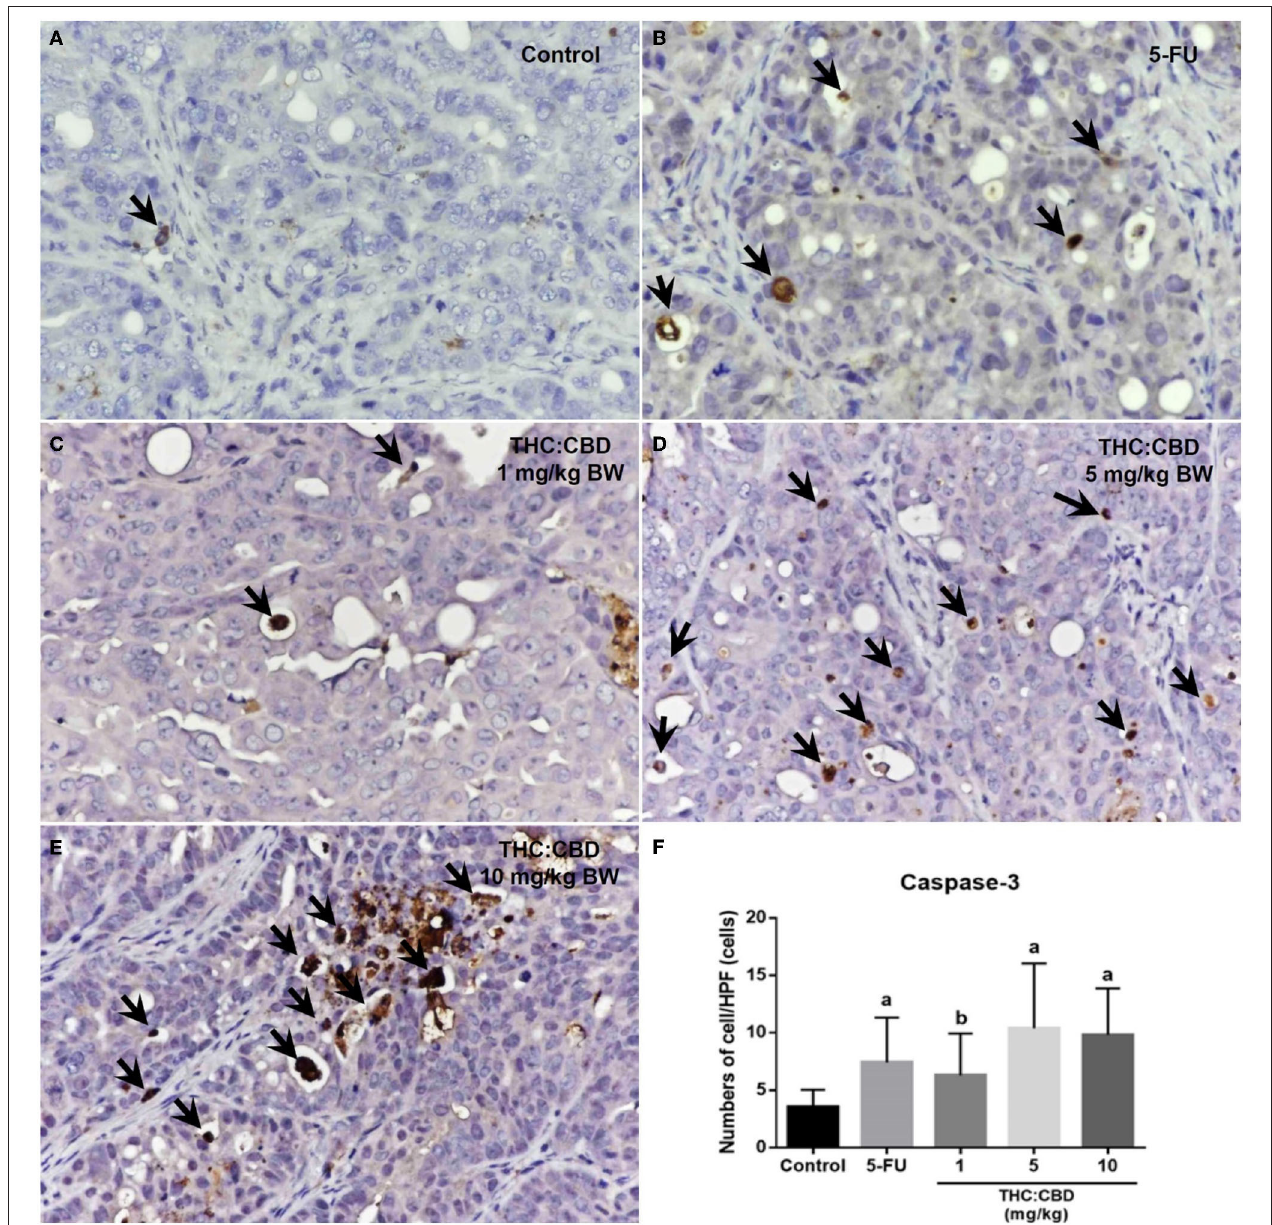
FIGURE 7 | Caspase-3 expression in the negative control group (A) , the positive control group (5-FU) (B) , and THC:CBD at the dose of 1, 5, and 10 mg/kg BW (C–E) , respectively. Caspase-3 positivity is presented by brown color (arrows) (counterstained with Mayer’s hematoxylin, 40 × ). The graph demonstrates the average number of caspase-3 positive cells per high-power field in the negative control group, the positive control group (5-FU), and THC:CBD doses of 1, 5, and 10 mg/kg BW. Data were expressed as mean ± SD. a indicates a significant difference at P < 0.05 compared to the negative control group. b indicates a significant difference at P < 0.05 compared to the positive control group (5-FU) (F)